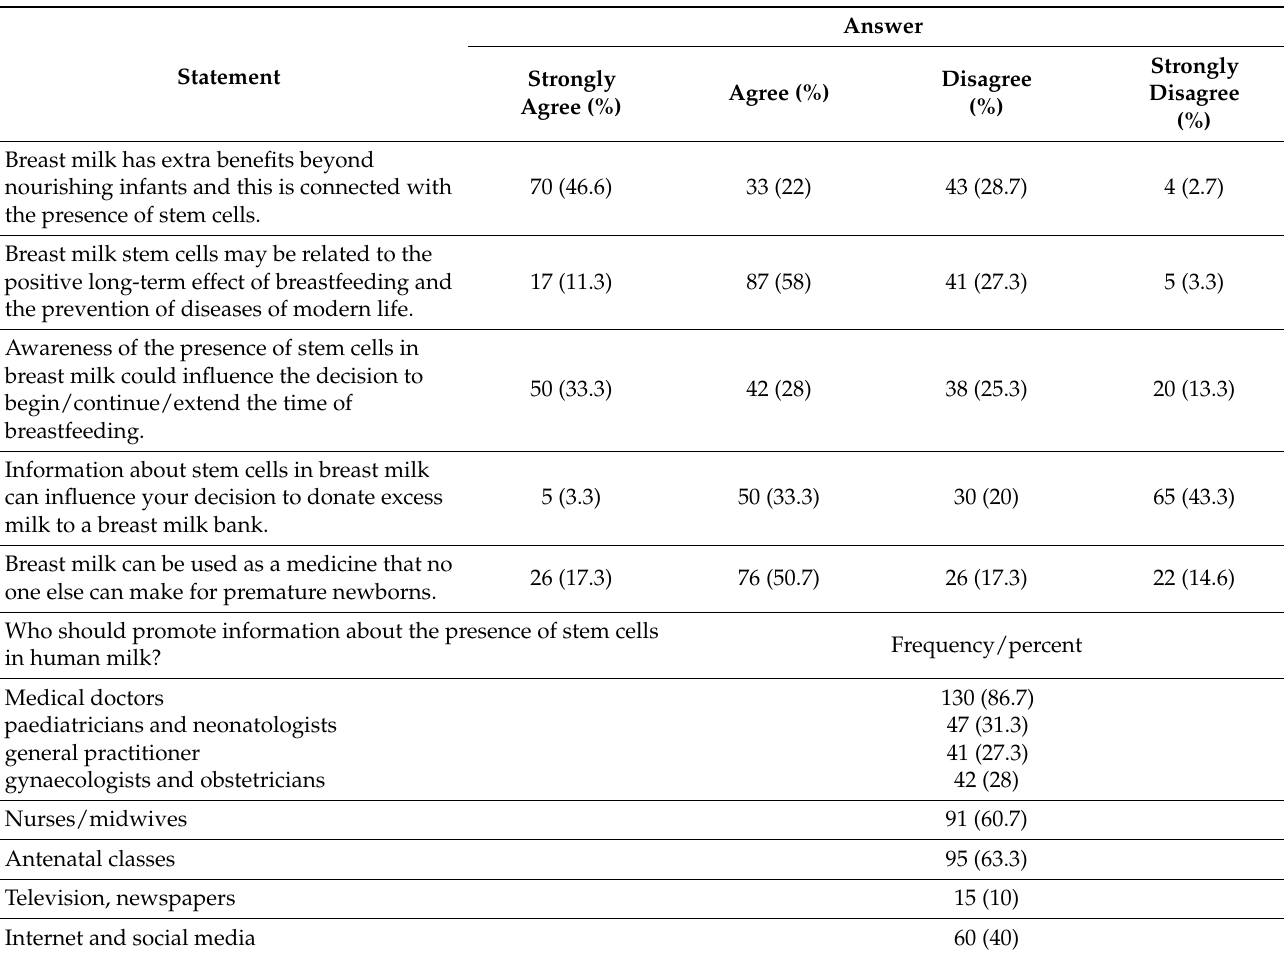
Table 4. Assessment of attitudes towards stem cells including breast milk stem cells among Polish pregnant